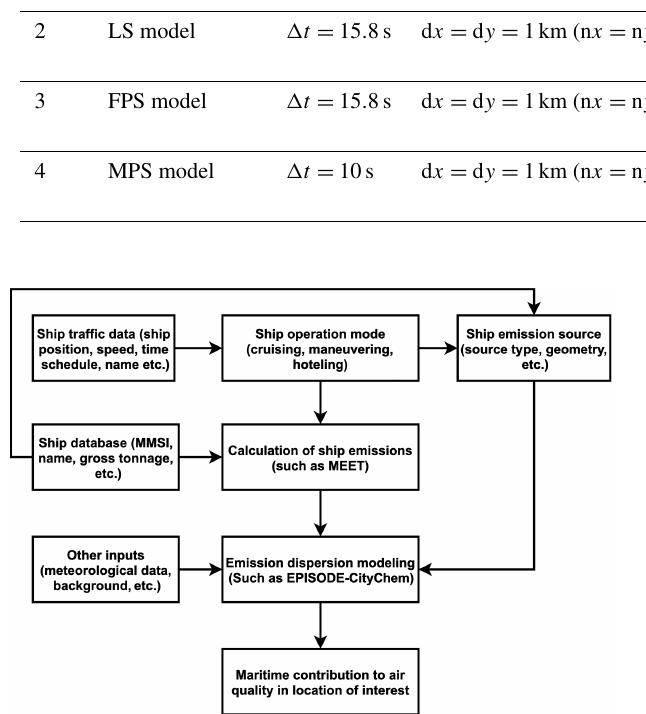
Figure 5. Shipping emission dispersion modeling with MEET method (Trozzi,